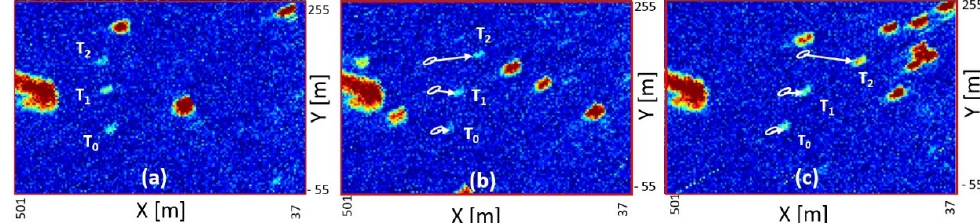
Figure 15. Movements of the targets within the survey area related to the third release. ( a ) Index instant 1320; ( b ) index instant 1461; ( c ) index instant 1567.